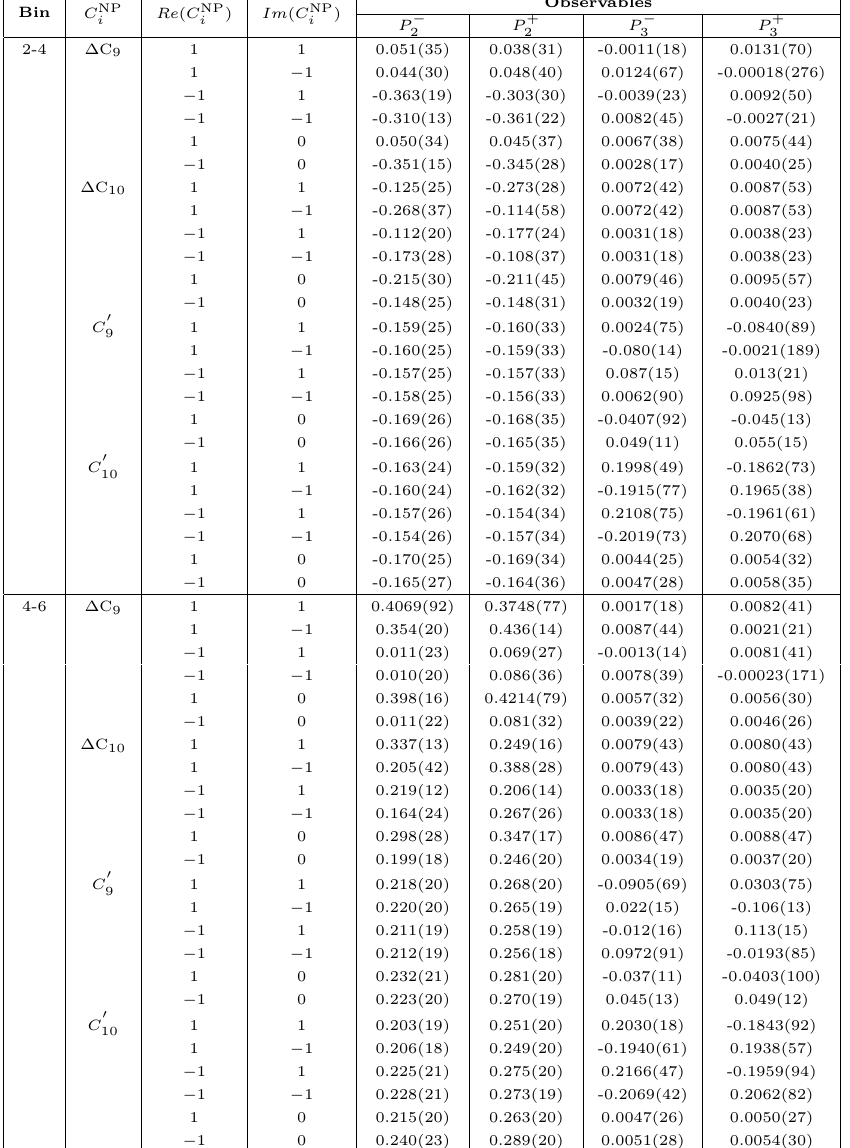
Table 29 . The dependence of some of the optimized observables corresponding to B + → ρ + ll and B − → ρ − ll on the real and imaginary parts of the NP WC’s ∆ C 9 , 10 and C 0 and 4 − 6 GeV 2 for a few benchmark values of the real and imaginary parts of the corresponding